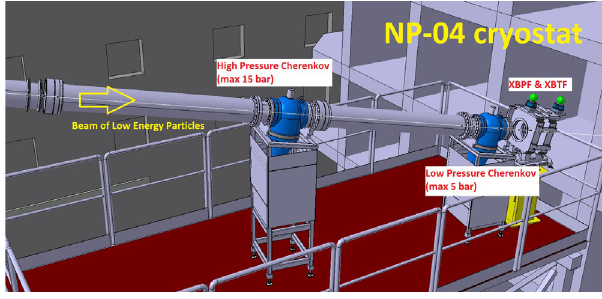
FIG. 14. The two Cherenkov detectors mounted in the H4-VLE beam line. One is able to sustain a radiator gas up to 15 bar and the other up to 5 bar. Inside the blue tank, a curved mirror deflects the Cherenkov photons created in the gas towards the photo- multiplier located in the bottom of the detector.